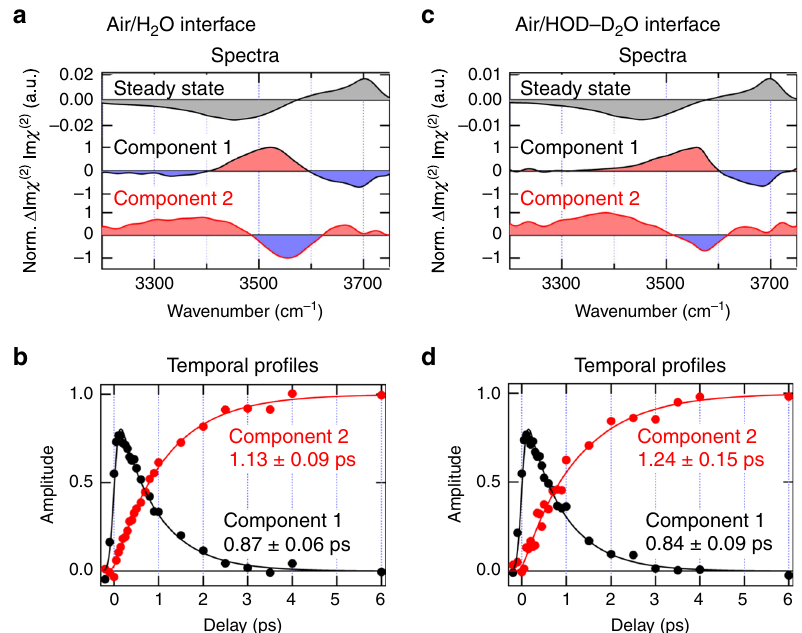
Fig. 3 Singular value decomposition (SVD) analysis of the time-resolved Δ Im χ (2) spectra. a , c The spectra and b , d the temporal pro fi les of the two major components obtained from SVD analysis of the time-resolved Δ Im χ (2) spectra from − 0.2 ps to 6.0 ps: a , b neat H 2 O and c , d isotopically diluted water (H 2 O/HOD/D 2 O = 1/2/1). Red and blue regions in the spectra ( a , c ) correspond to the positive and negative changes from the steady-state Im χ (2) spectrum, respectively. The solid lines in b , d show the exponential fi ts for the decay and rise of the components, taking account of the instrumental response (200-fs